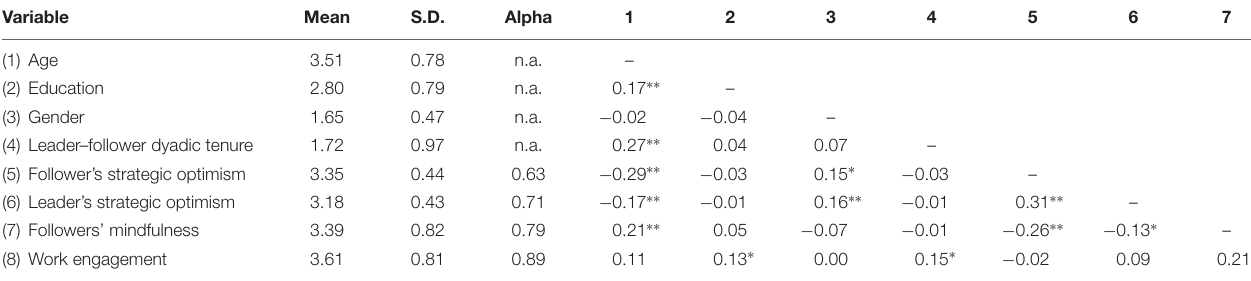
TABLE 1 | Means, standard deviations, alpha reliabilities, and correlations among variables a , b , c . Variable